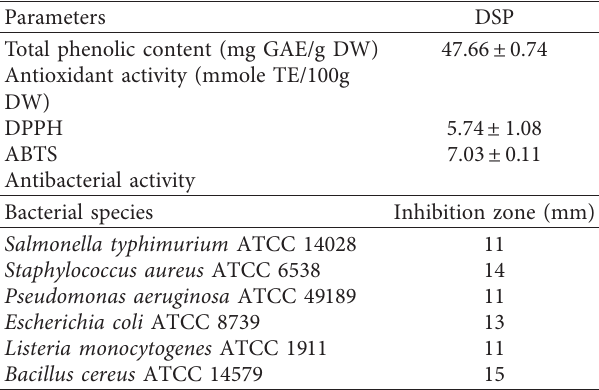
Table 4: Total phenolic content, antioxidant activity, and anti- bacterial activity of